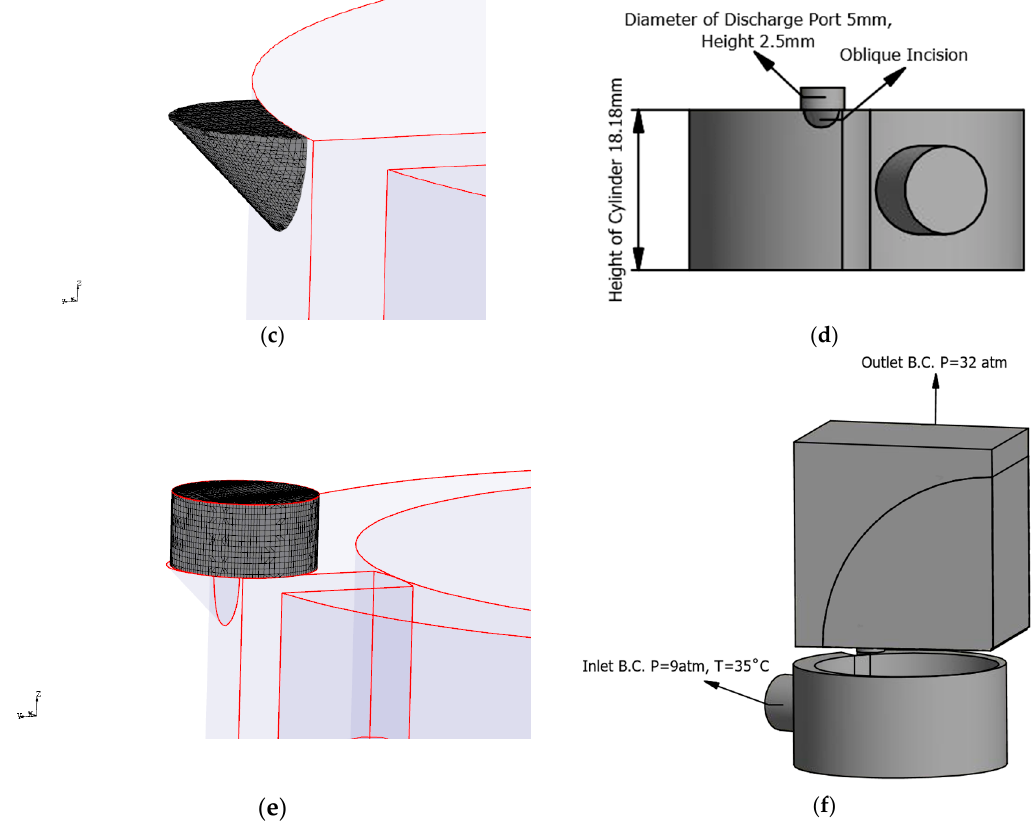
Figure 1. Geometry of Model and boundary conditions: ( a ) basic profile of the compressor; ( b ) location of reed valve, ( c ) oblique incision; ( d ) side view of the compressor € discharge port; ( f ) boundary conditions.